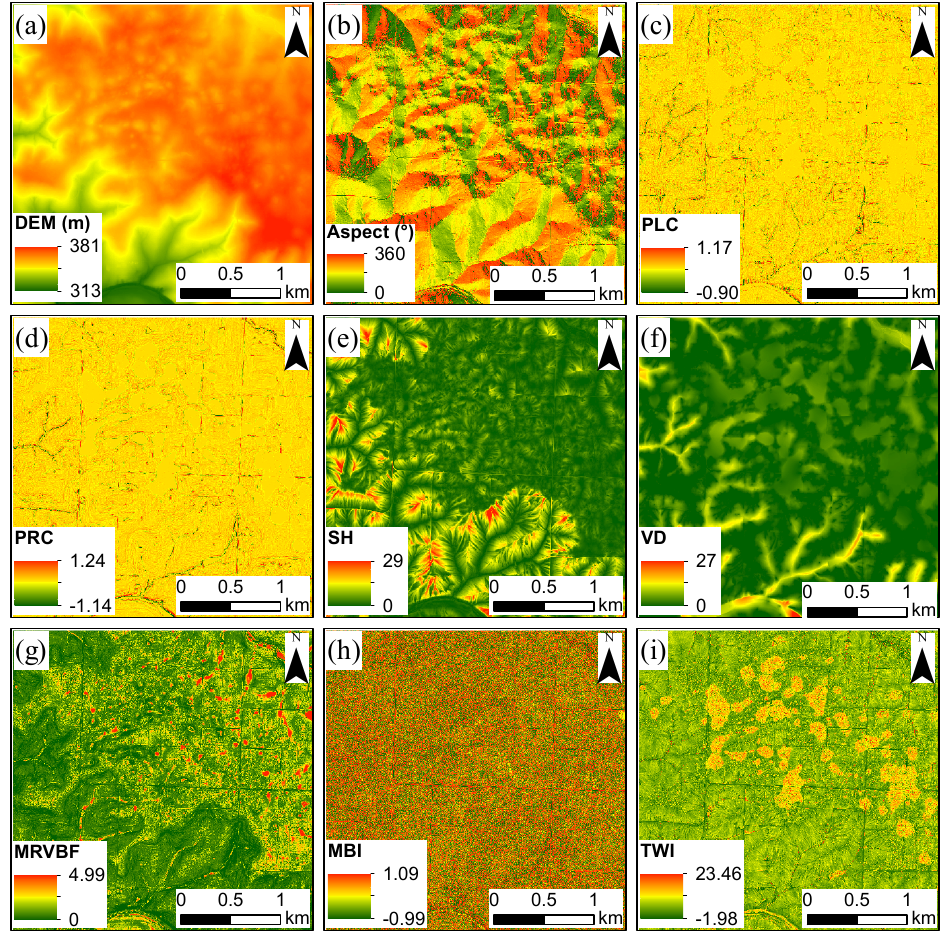
Figure 3. Geomorphometric indices of the study area used for the final model: ( a ) DEM; ( b ) aspect; ( c ) PLC; ( d ) PRC; ( e ) SH; ( f ) VD; ( g ) MRVBF; ( h ) MBI; and ( i ) TWI.